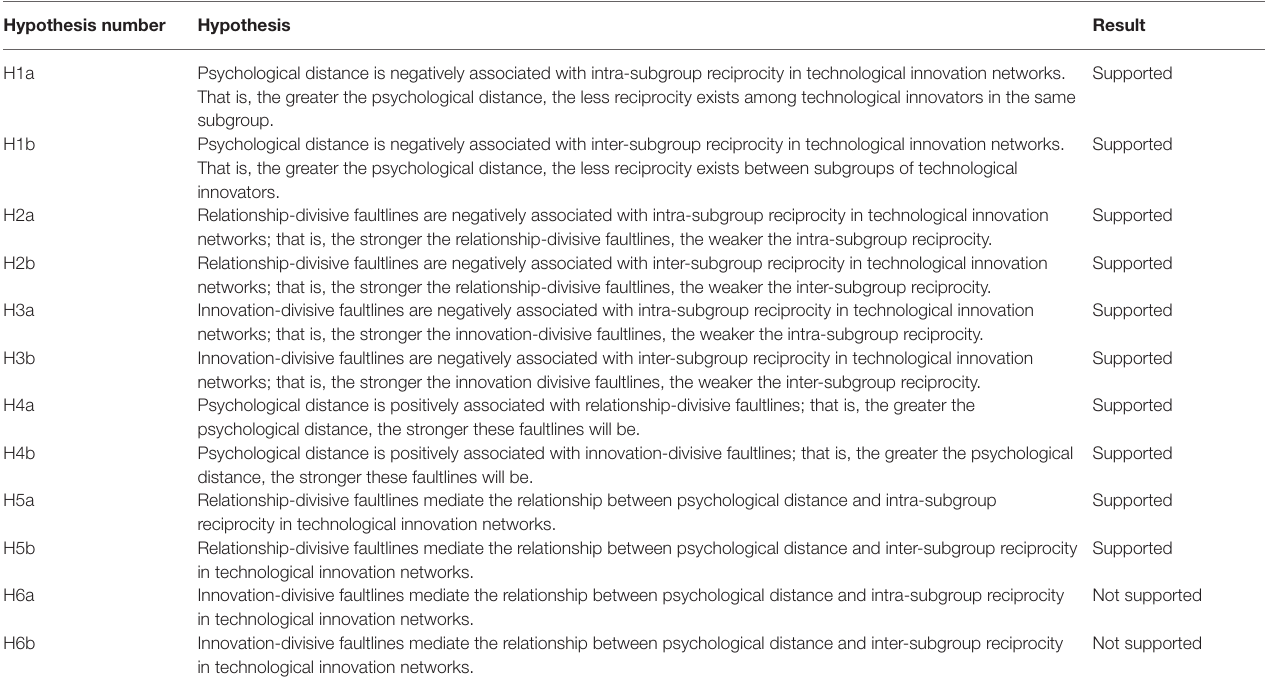
TABLE 10 | Results of the hypothesis